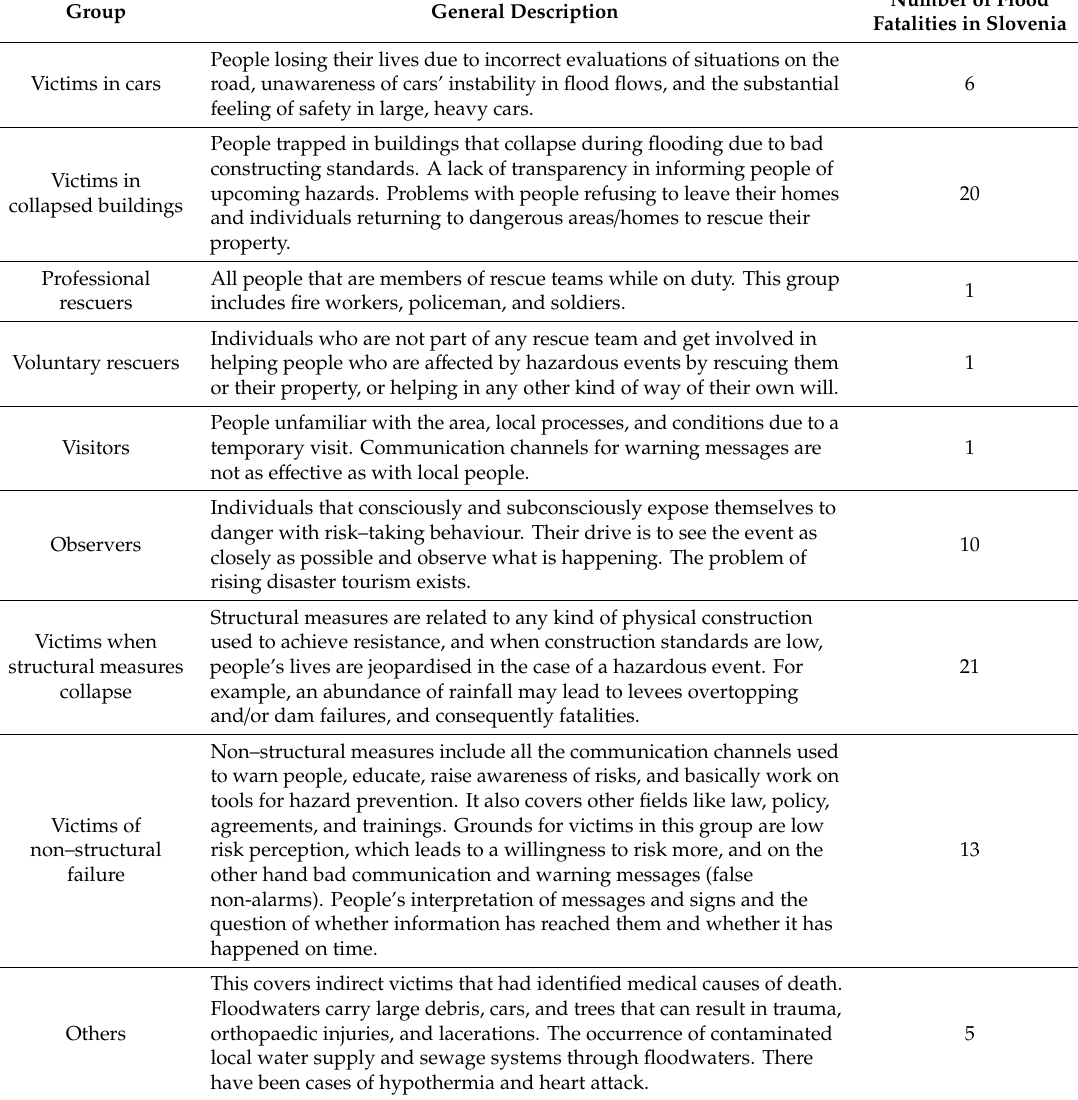
Table 1. Types of flood